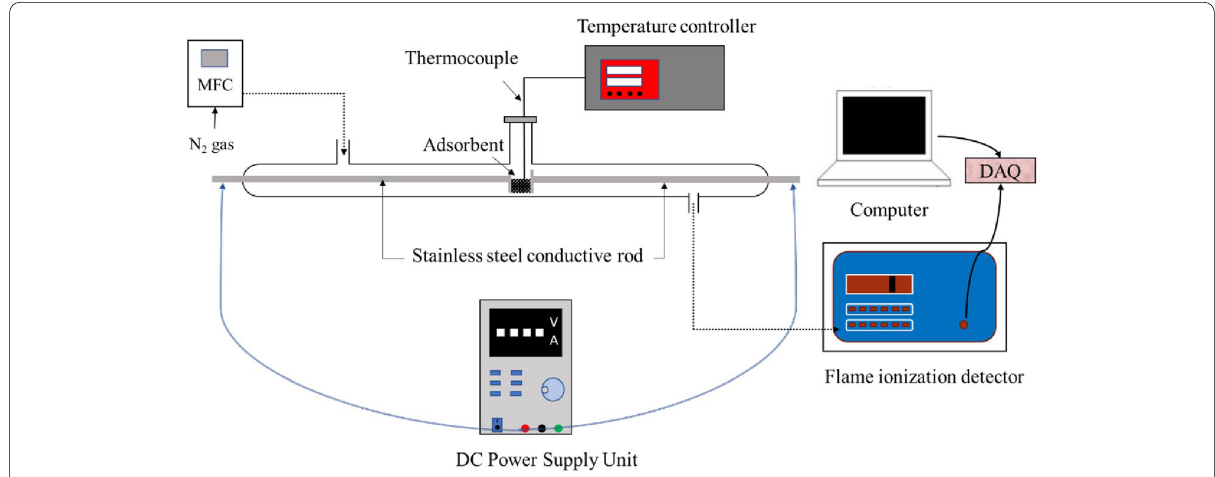
Fig. 3 Electrothermal swing system with FID signal acquisition